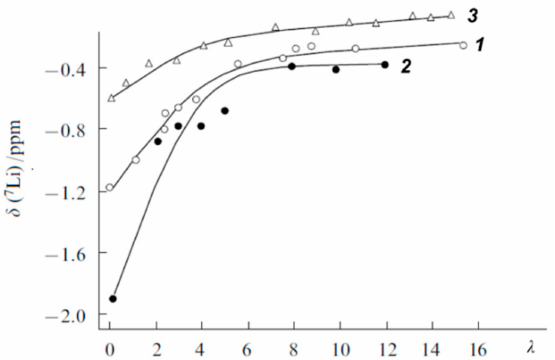
Figure 14. Dependences of chemical shifts in 7 Li NMR spectra on the moisture content of the Li + forms of perfluorinated sulfonate cation-exchange membranes MF-4SC (1), Nafion 117 (2), and car- boxylic membranes F-4CF (3). Reprinted with permission from [21]. Copyright 2010 Springer Nature.